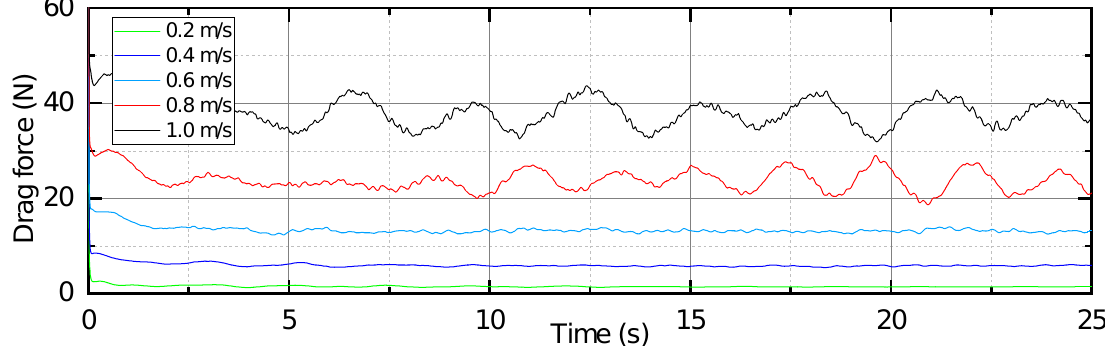
Figure 12. Surge force time series under the current velocity ranging from 0.2 m/s to 1.0 m/s.